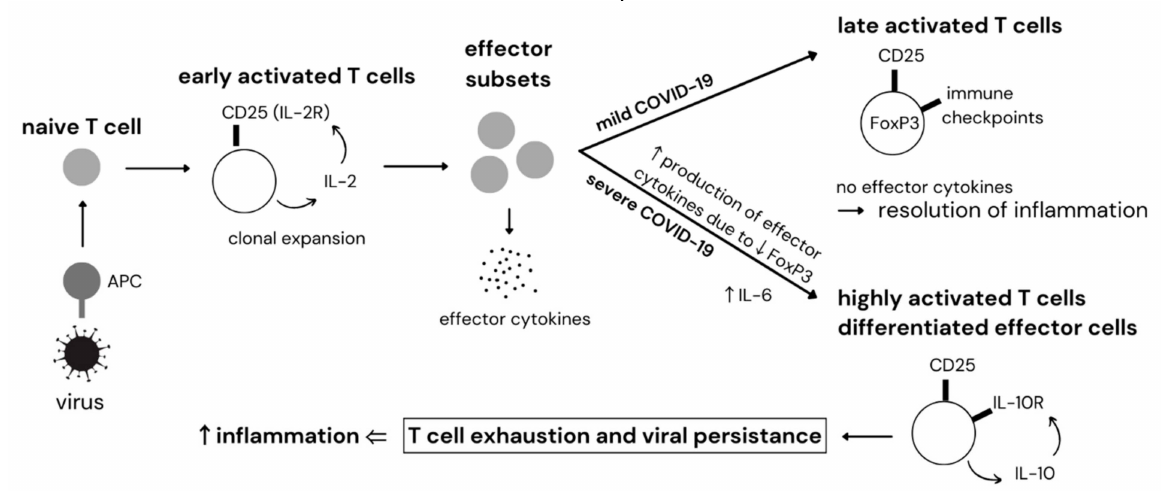
Figure 3. Dysregulation of T cells in COVID-19. APC—antigen-presenting cell, CD25—cluster of differentiation 25, FOXP3—forkhead box-P3, IL—interleukin, IL-2R—interleukin 2 receptor, IL-10R— interleukin 10